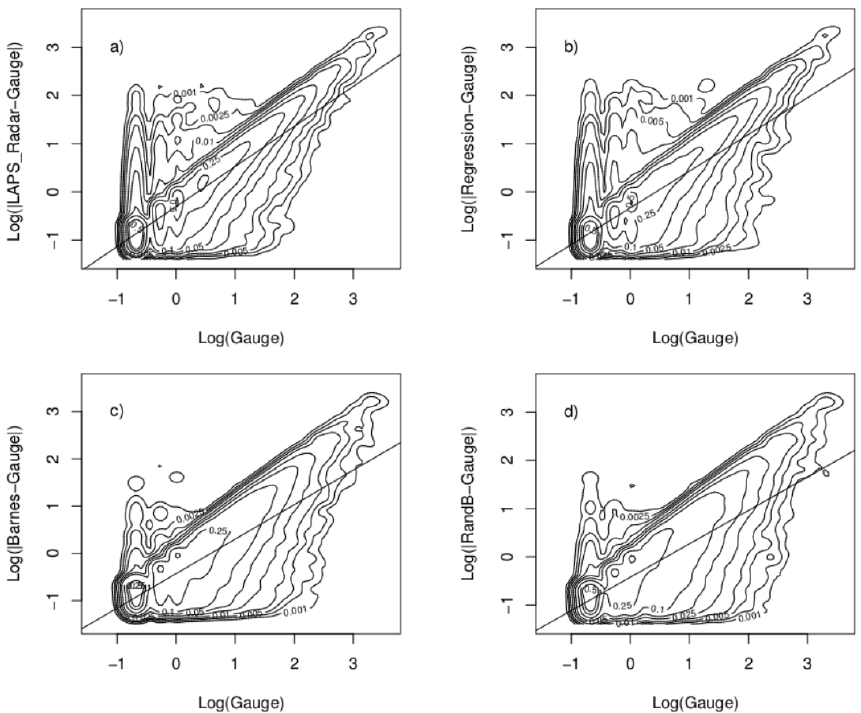
Fig. 3. Absolute value of the difference between observed and analyzed precipitation accumulation ( y axis) plotted against observed rain- gauge values ( x axis), for the dependent stations: (a) | LAPS_radar-Gauge | ; (b) | Regression-Gauge | ; (c) | Barnes-Gauge | , and (d) | RandB- Gauge | . The continuous line is a linear fit to the data